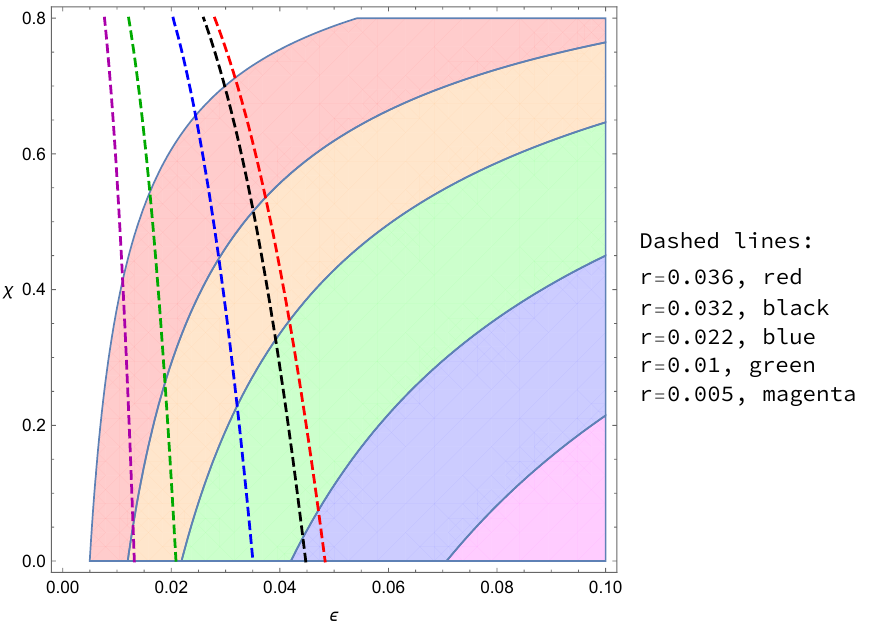
Figure 9 . Space of parameters (cid:15) and χ in the case µ = 1 . Colored strips correspond to different ratios of strong coupling scale to classical scale: 1 < E strong /E cl < 1 . 8 (red), 1 . 8 < E strong /E cl < 2 . 7 (orange), 2 . 7 < E strong /E cl < 4 . 2 (green), 4 . 2 < E strong /E cl < 6 (blue), 6 < E strong /E cl (magenta). Dashed lines show the tensor-to-scalar ratio: r = 0 . 005 (magenta), r = 0 . 01 (green), r = 0 . 022 (blue), r = 0 . 032 (black), and r = 0 . 036 (red).